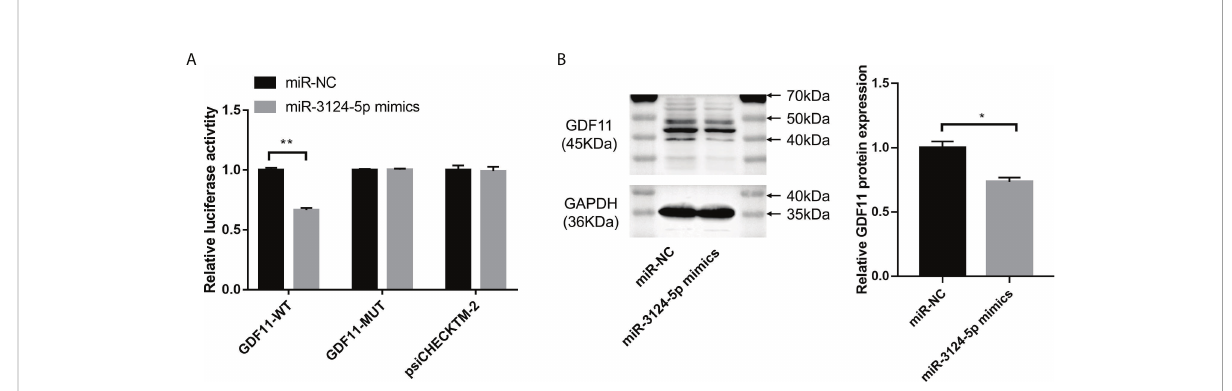
FIGURE 6 miR-3124-5p targeted GDF11 and downregulated GDF11 expression. (A) Luciferase activity assay con fi rmed that miR-3124-5p could target GDF11-WT. (B) Western blot assay showed GDF11 protein expression in miR-3124-5p mimic group and miR-NC group. Compared to miR-NC group, * p < 0.05, ** p <